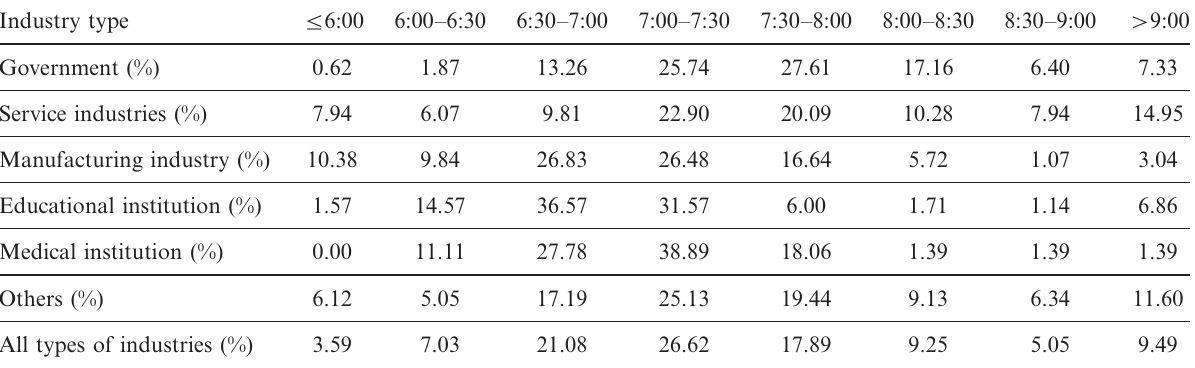
Table 2. Current distribution of the departure time from home